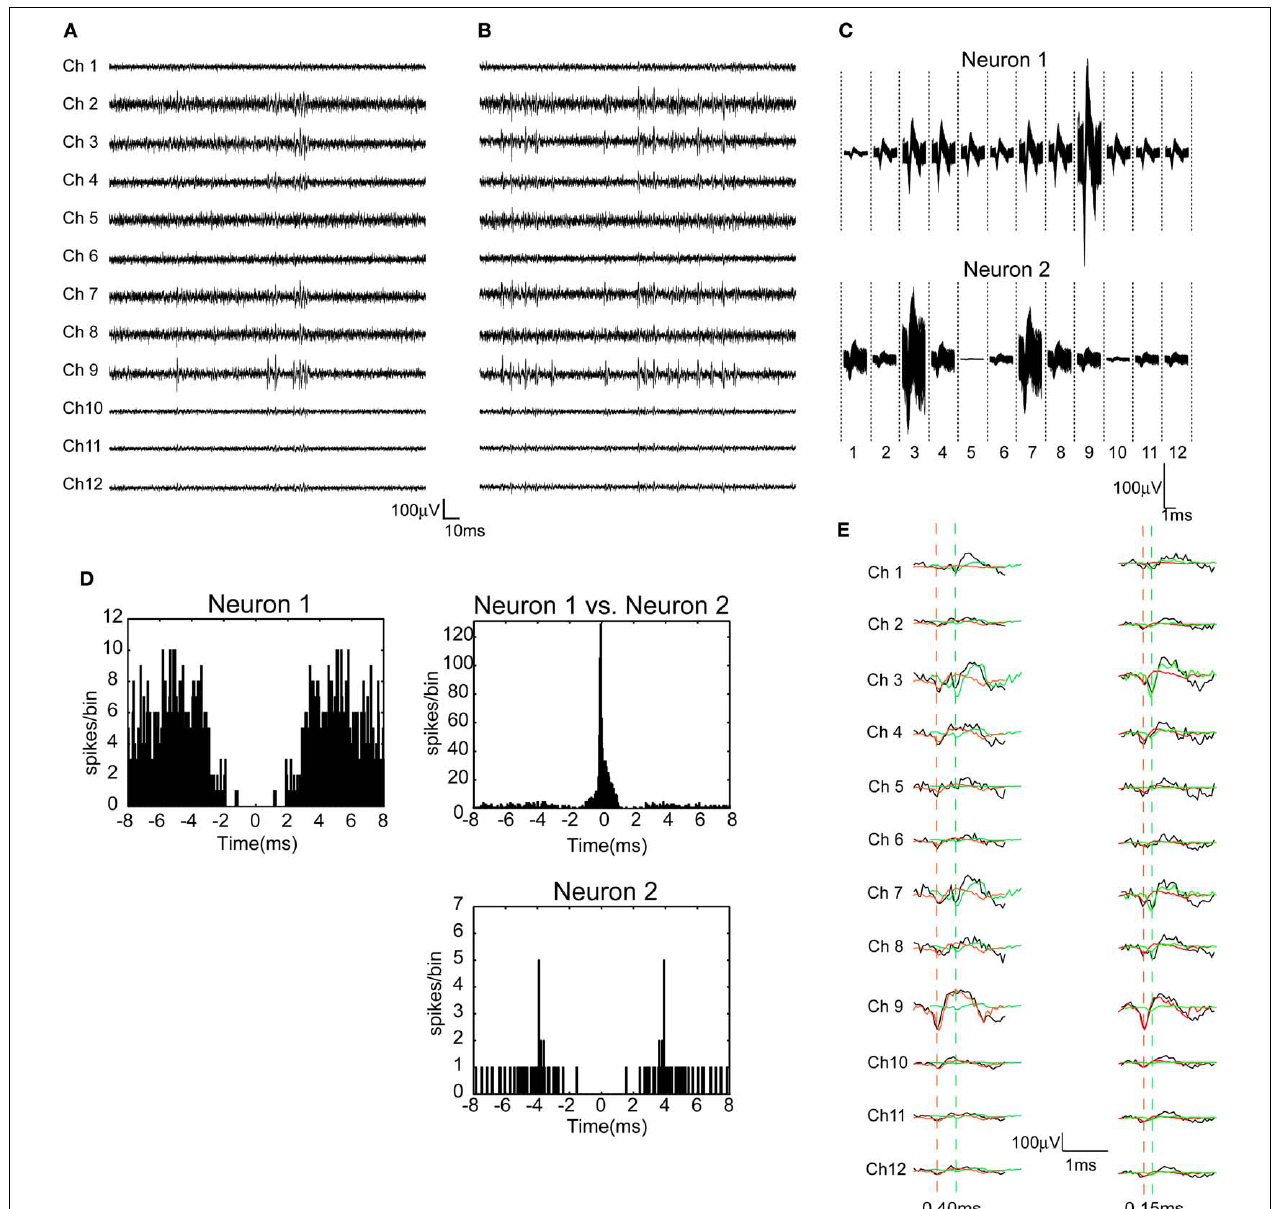
scaled channel by channel (see Materials and Methods). (D) Auto- and cross-correlograms between neurons 1 and 2. The bin size is 50 µs. (E) Overlapped (black solid lines) and separated waveforms reconstructed from independent components identifi ed as neurons 1 and 2 (red dashed lines separated waveforms of neuron 1, green dashed lines separated waveforms of neuron 2). Neurons 1 and 2 co-fi re respectively with a jitter of 0.40 ms (left) and 0.15 ms